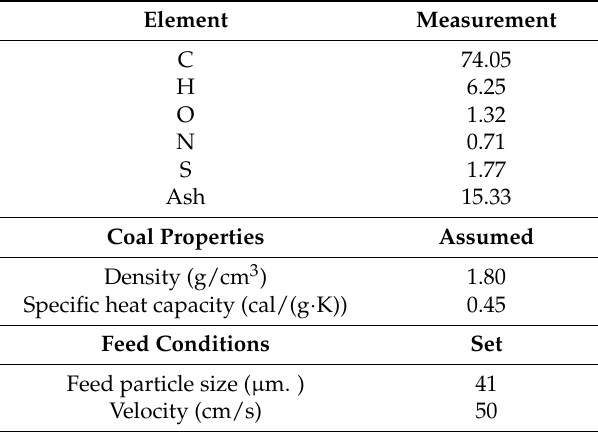
Table 5. Element analysis (wt %), coal properties, and feed conditions that were used in this study.